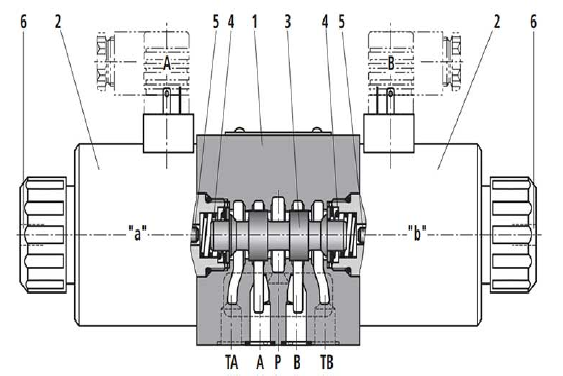
Figure 1. A typical HSV; two solenoids "a" and "b," (1) valve body, (2) solenoid coil, (3) valve spool, (4) return spring, (5) solenoid plunger, (6) press pin.